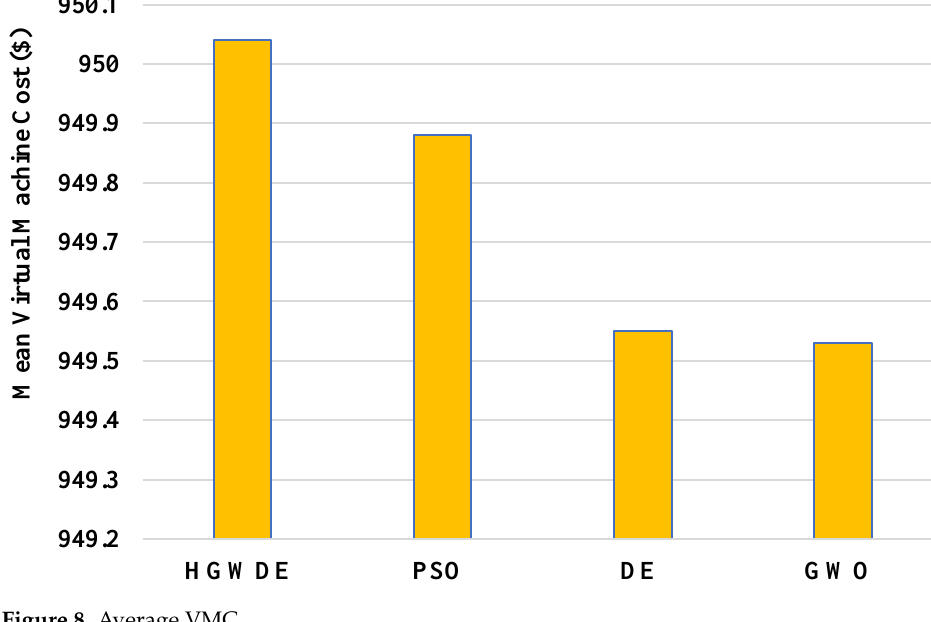
Figure 8. Average VMC.